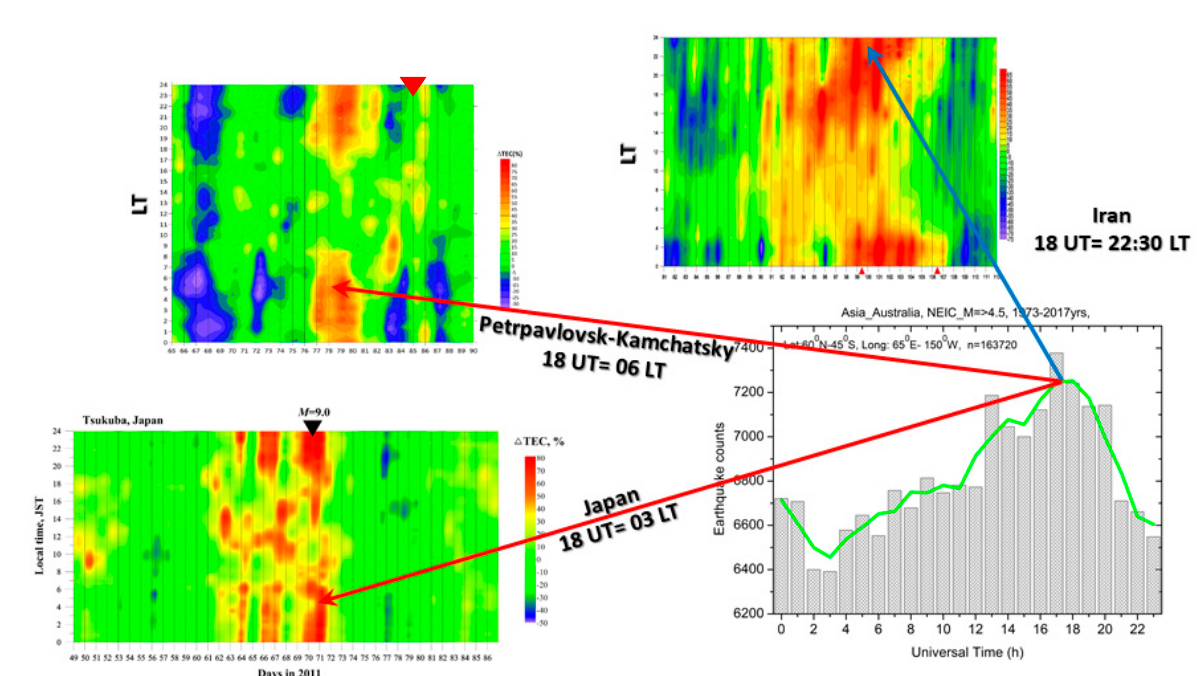
Figure 13. Night-time positive precursory anomalies for three major earthquakes: the M6.3 Bushehr earthquake of 9 April 2013, the M9 Tohoku earthquake in Japan on 11 March 2011, and the M7.5 earthquake that struck east of the Kuril Islands earthquake on 25 March 2020 in comparison with the UT distribution of earthquakes in the Asian–Australian longitudinal sector.